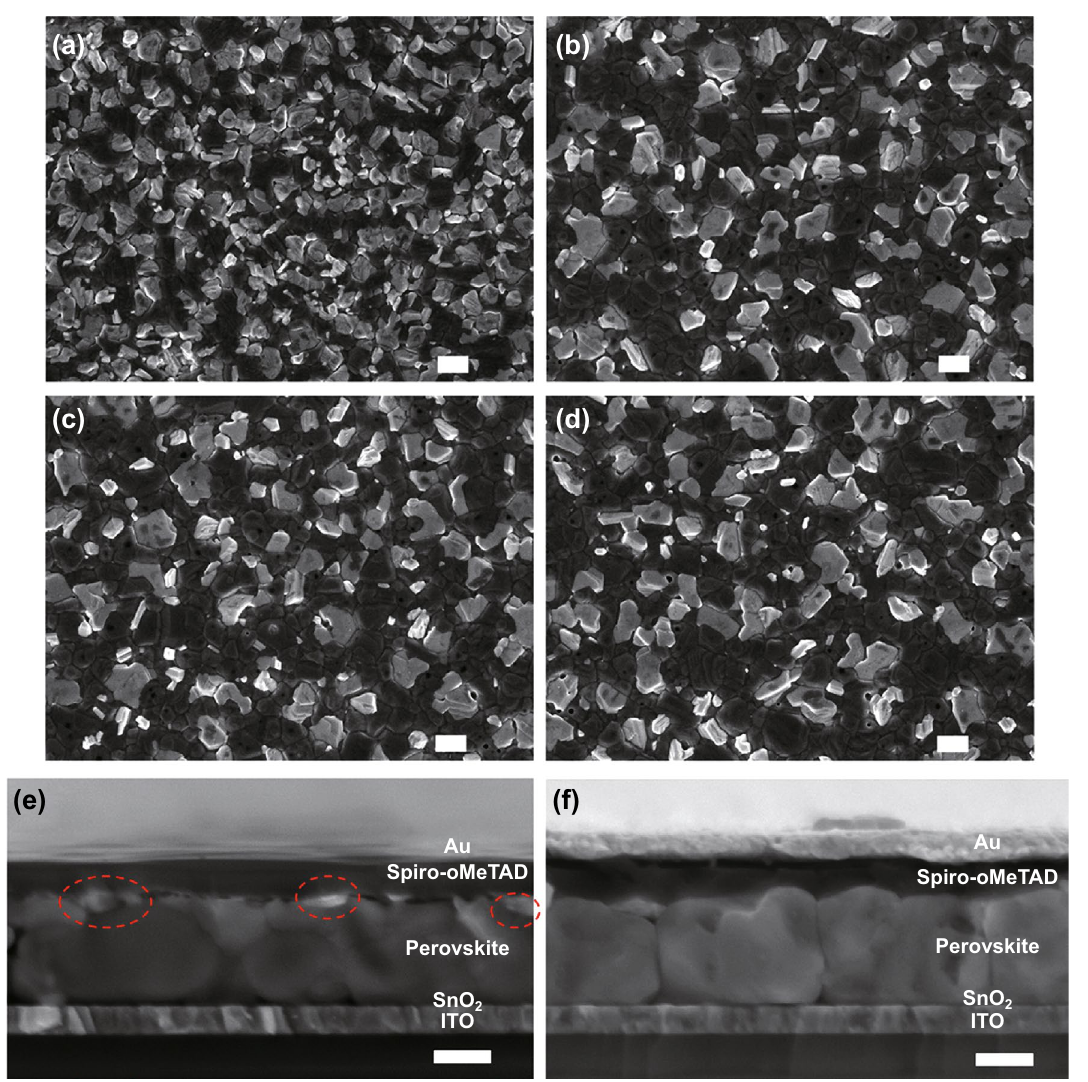
Fig. 2 Top‑view SEM images of postdeposition annealed perovskite films: a control sample without aging, b LTAG‑30‑treated sample, c LTAG‑50‑treated sample, and d LTAG‑70‑treated sample. Cross‑sectional SEM images of e control and f LTAG‑30‑treated device; the scale bars: 1 μm ( a–d ); 500 nm ( e, f